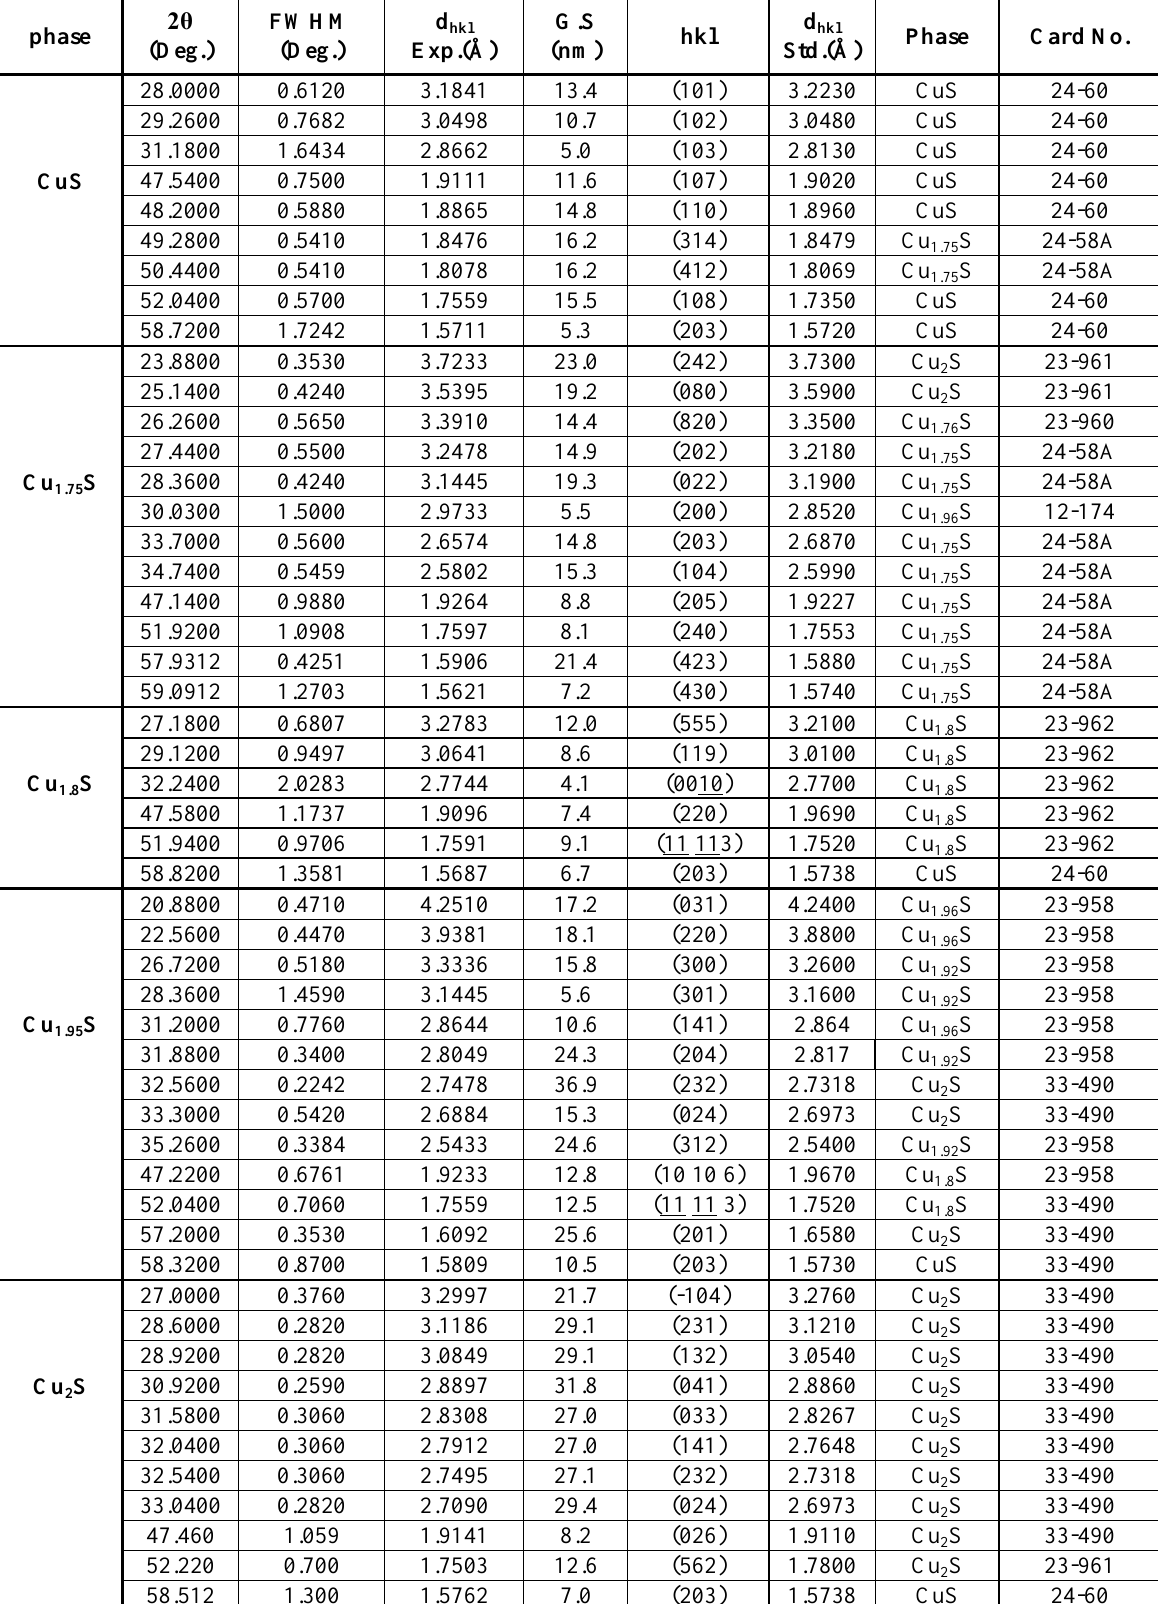
S powders at different molar 2-x